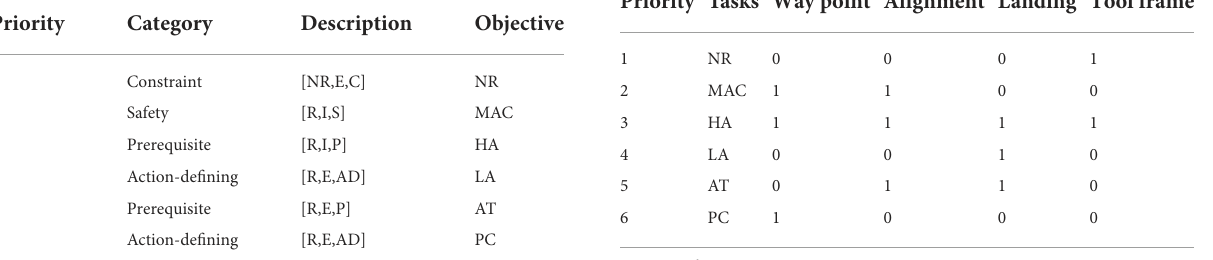
TABLE 3 Control tasks and priorities for fixed base manipulation operations.